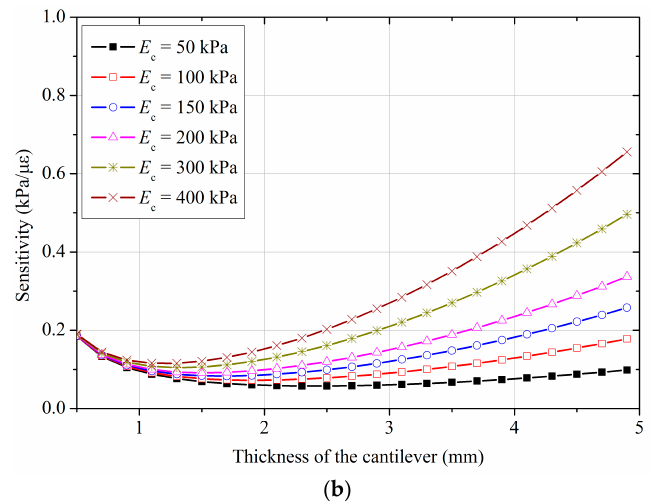
Figure 8. Sensitivity of the designed FPS with various Young’s modulus and ( a ) width, and ( b ) thickness of the cantilever.